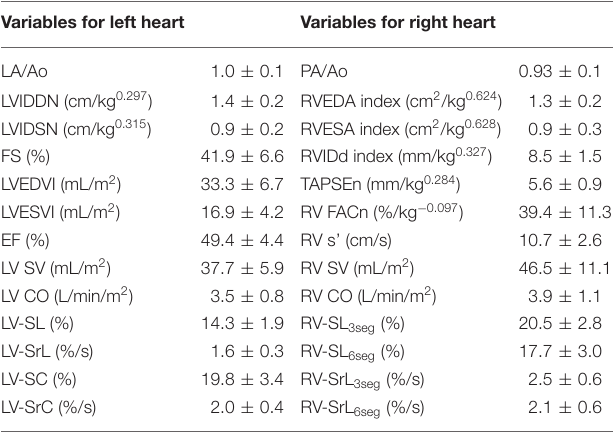
TABLE 1 | Results of echocardiographic variables of eight canine models of chronic pulmonary hypertension at study inclusion. Variables for left heart Variables for right heart